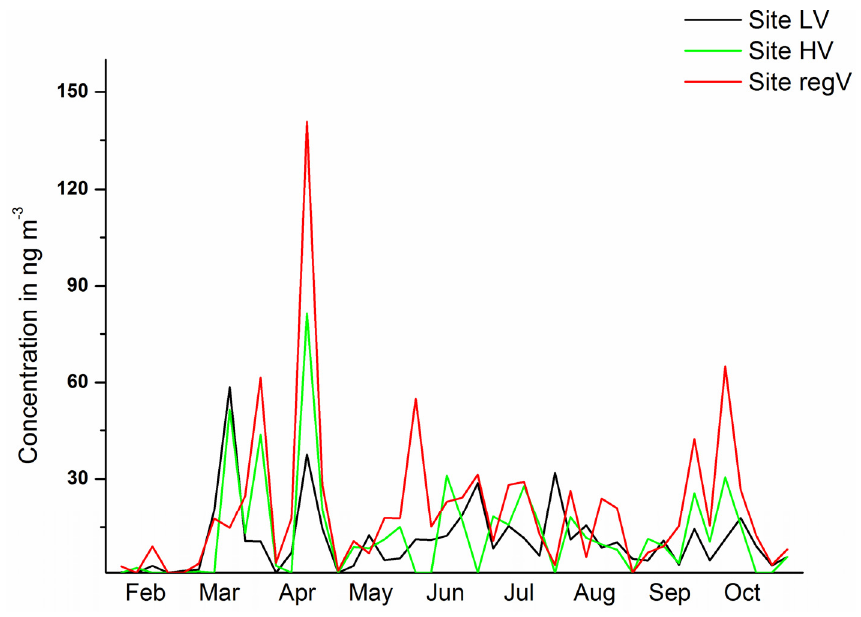
Figure 1. PM -SOA-concentrations from compound analysis. Secondary organic aerosol 10 (SOA) is given by the sum of the compounds pinic acid, pinonic acid, 2-Methylthreitol and 2-Methylerythritol